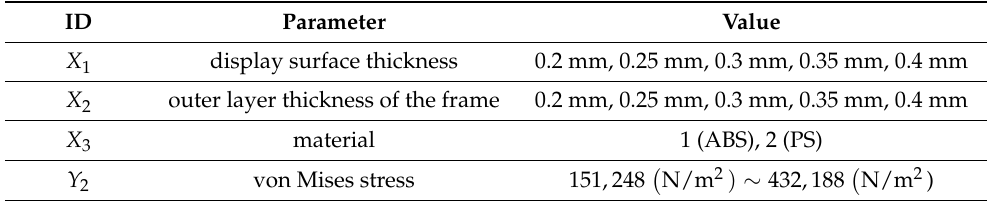
Table 2. Definitions of RSM parameters for the mechanical strength